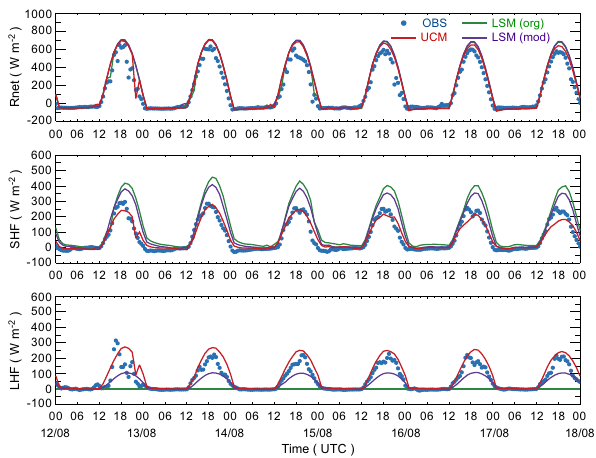
Fig. 8. Diurnal variations of the observed and simulated net all- wave radiation, sensible heat flux, and latent heat flux (top to bot- tom) at the Brenham site from 12 to 17 August 2006. This site is represented as a low-density residential area in the model.